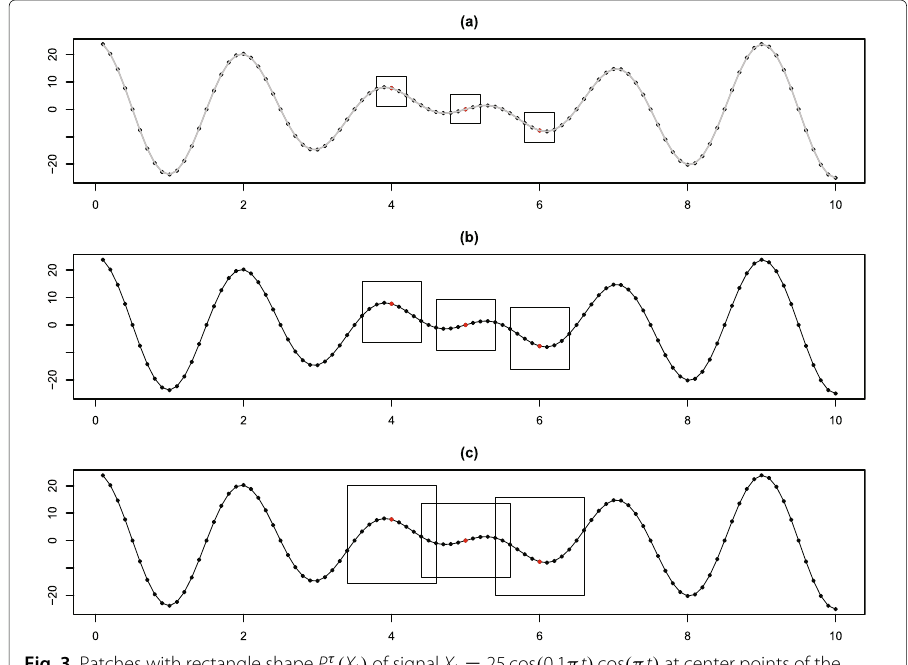
( X ) of signal X = 25cos ( 0.1 π t ) cos (π t ) at center points of the t t i